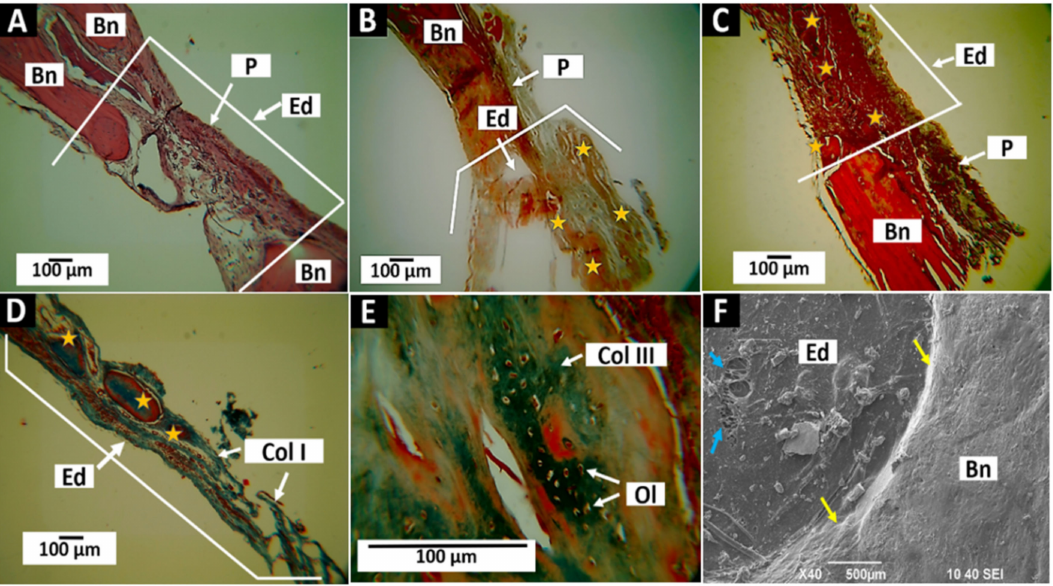
Figure 5. Healing of the control defect. ( A ): Preparation at 30 days at 10 × . Hematoxylin—Eosin (HE) technique. ( B ): Preparation at 60 days at 10 × . GT technique. ( C ): preparation at 90 days at 10 × . HE technique. ( D ): Preparation at 90 days at 10 × . Masson’s Trichrome (MT) and Gomori’s Trichrome (GT) (MT) technique. ( E ): Preparation at 90 days at 40 × . GT technique. ( F ): Preparation at 30 days, SEM technique at 40 × . Bn: bone. Ed: Empty defect. P: Periosteum. Stars: Nodules of bone formation. Yellow arrows: Interface preparation—Bone. Blue star: Unsealed or perforated areas. Col I: Type I Collagen. Col III: Type III collagen. Ol: Osteocytic